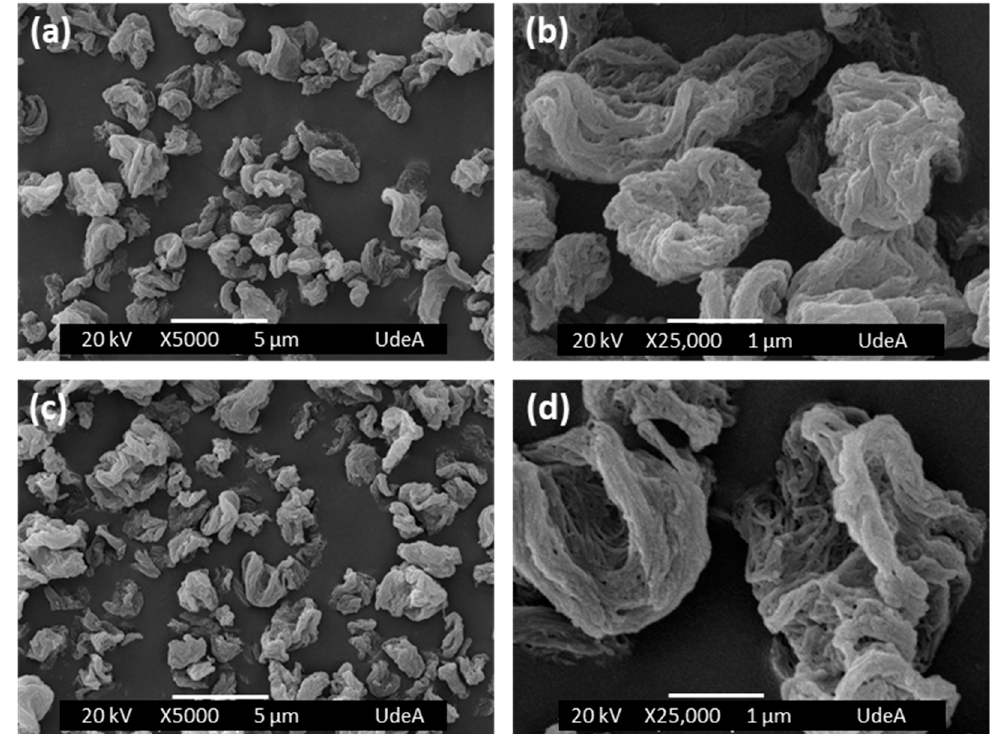
Figure 1. SEM images of spray-dried capsules. ( a , b ) BNC capsules and ( c , d ) BNC/GEN capsules.